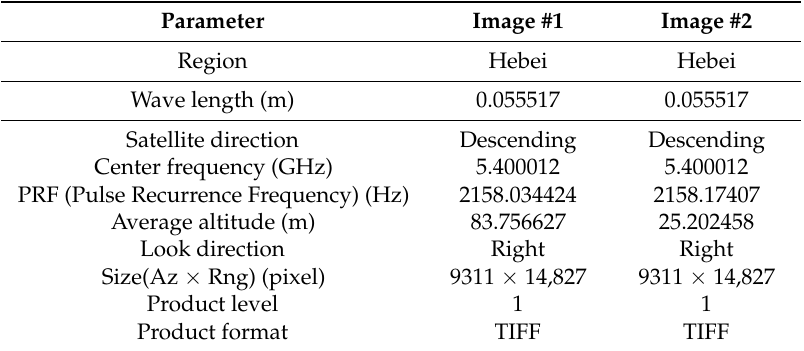
Figure 7. Experimental data: ( a ) the master image of the experiment; ( b ) the slave image of the experiment. The main parameters of the data used in the experiment are shown in Table 2. Table 2. The basic Information about the two GF-3 SAR images employed in the experiment.